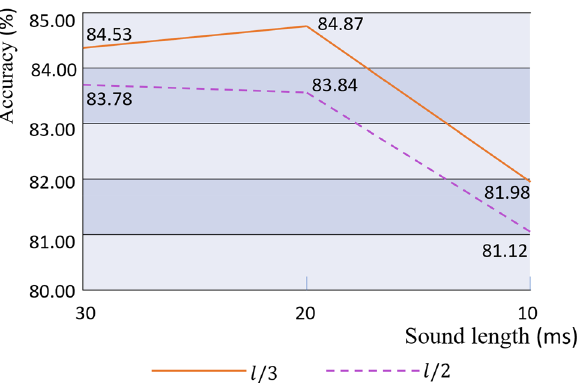
Figure 11. Accuracy of engine sound logarithmic Mel spectrogram under different